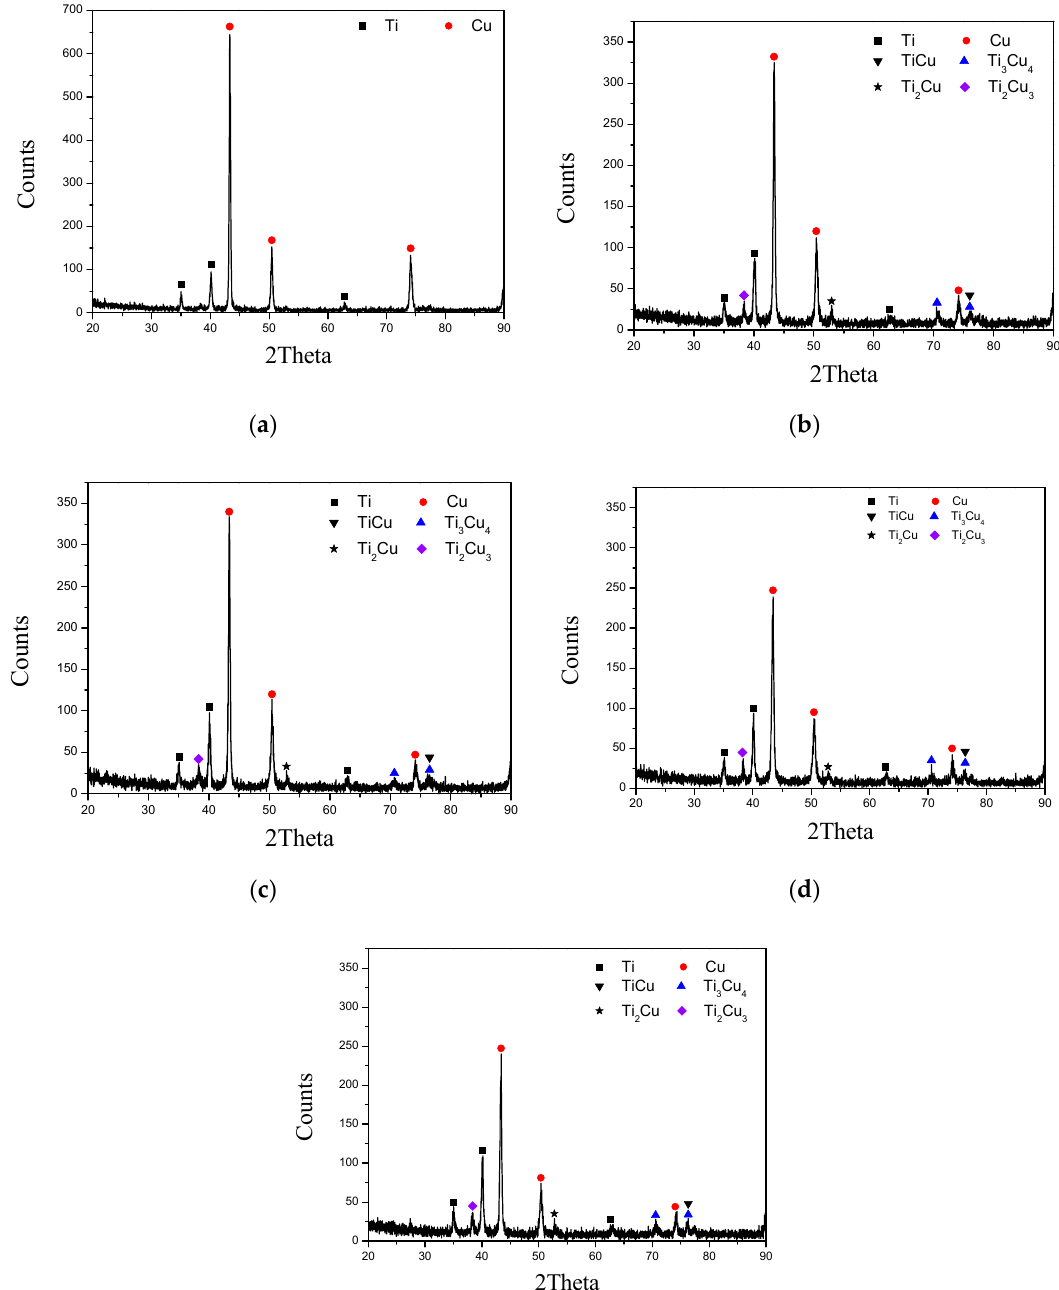
Figure 3. XRD patterns of titanium clad materials: ( a ) as-rolled sample, and samples annealed at 450 °C for ( b ) 0.5 h, ( c ) 1 h, ( d ) 2 h, and ( e ) 4 h.